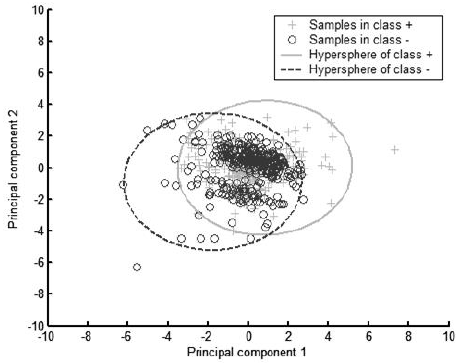
Figure 1. Principal components plot of SVDD for Australia data set.